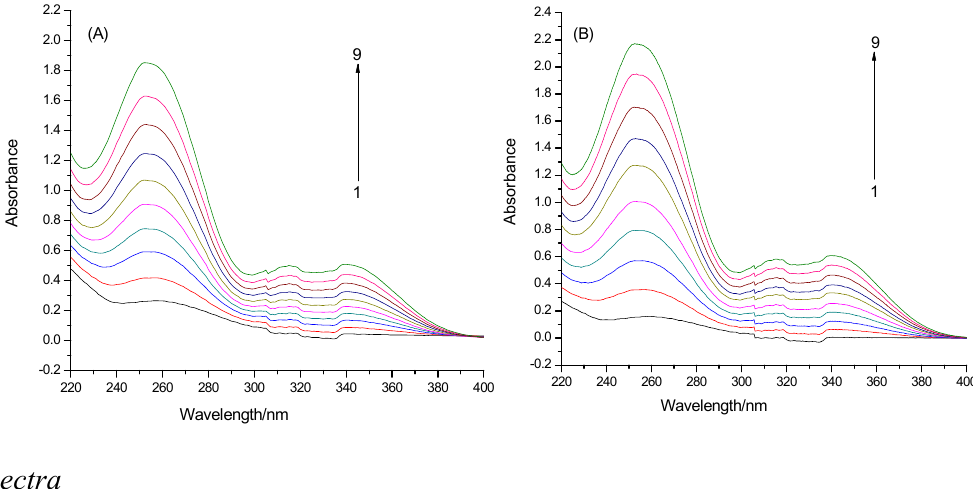
Figure 3. UV-vis spectra of CYPs with different concentrations of puerarin (concentrations of puerarin (1 → 9): 0, 0.5, 1, 1.5, 2, 2.5, 3, 3.5 and 4 × 10 − 5 mol L − 1 ). ( A ) puerarin-CYP1A2; ( B )